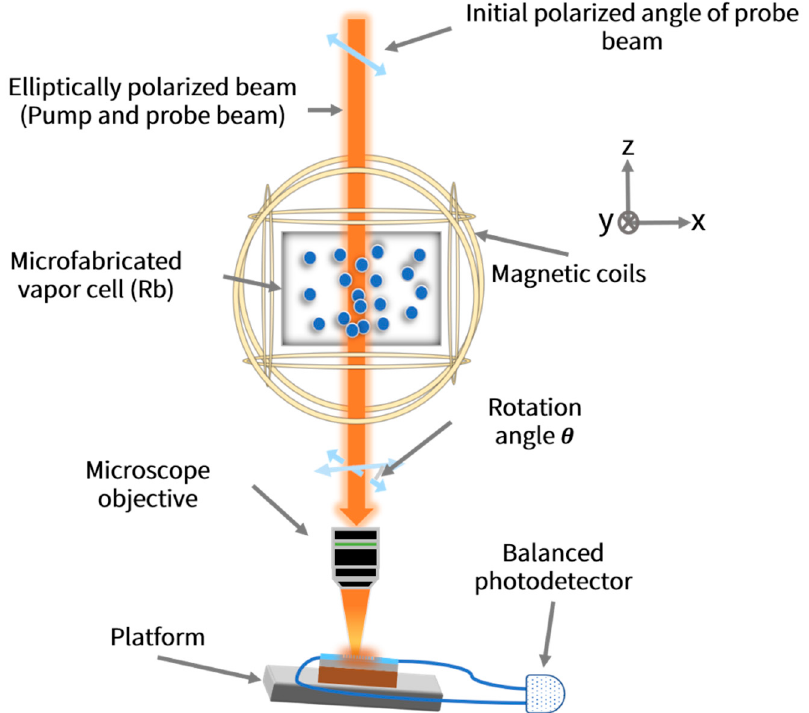
Figure 11. Schematic sketch of chip-scale AM demonstrated in this study according to the polarization splitting grating coupler with horizontal integration.